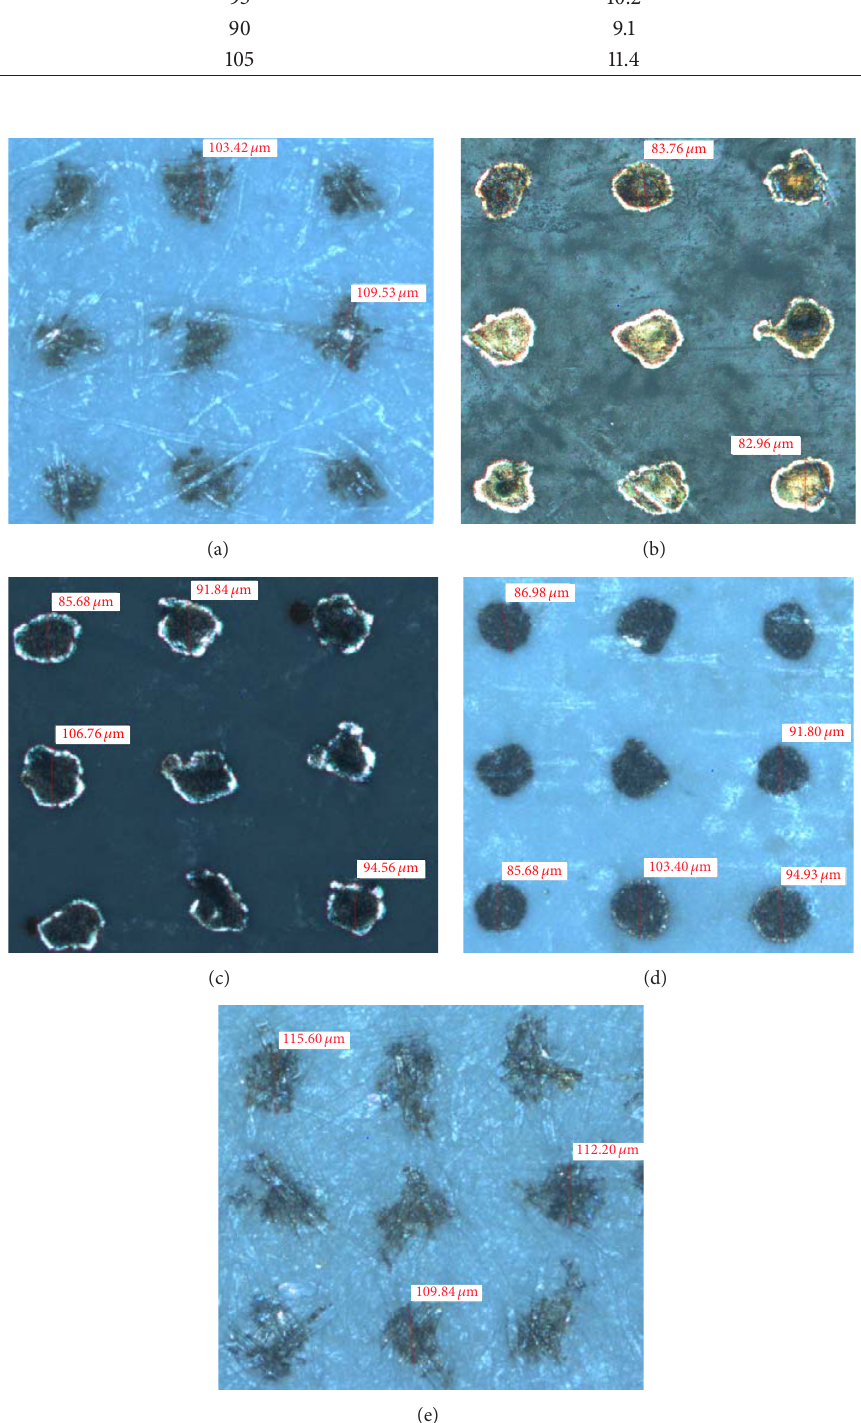
Figure2:Dropletsizetestonallsubstrates:(a)dropletsonPaperA,(b)dropletsonPaperB,(c)dropletsonPaperC,(d)dropletsonCardboard A, and (e) droplets on Cardboard